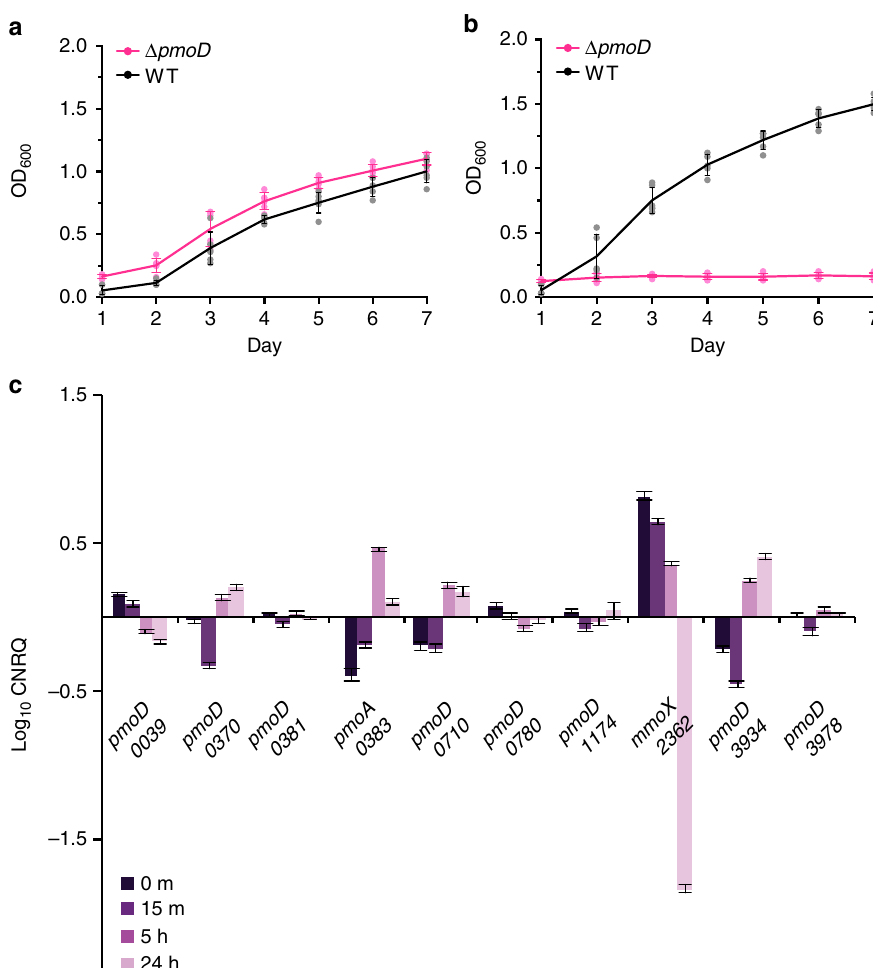
Fig. 3 In vivo characterization of PmoD MettrDRAFT_0381 . a Growth curves of wild-type (black) and Δ pmoD (pink) Methylosinus trichosporium OB3b under copper starved conditions. Error bars represent s.d., n = 5 – 6. b Growth curves of wild-type (black) and Δ pmoD (pink) Methylosinus trichosporium OB3b grown in the presence of 10 μ M CuSO 4 . Error bars represent s.d., n = 5 – 6. c qPCR analysis of pmoD genes in Methylosinus trichosporium OB3b at four timepoints (0 min at 0 μ M CuSO 4 , 15 min at 12.5 μ M CuSO 4 , 5 h at 12.5 μ M CuSO 4 , 24 h at 12.5 μ M CuSO 4 ) . Regulatory changes are shown as log 10 - transformed normalized relative quantities (NRQs). The four-digit code beneath the gene name represents the locus tag (in MettrDRAFT_NNNN format). Two non- pmoD genes are included for comparison: components of the two MMOs, pMMO ( pmoA_0383 ) and sMMO ( mmoX_2362 ), which are reciprocally regulated by copper. The clearest copper-responsive regulation is observed for the copC -adjacent pmoD MettrDRAFT_0039 (the genes are both copper down-regulated, and regulatory changes are correlated with those observed for components of the mmo and mbn operons) and for the pCu A C -adjacent pmoD MettrDRAFT_3934 (the genes are both copper up-regulated, and regulatory changes are correlated with those observed for components of the pmo operon and csp1 ). Error bars represent standard error between three biological replicates, each containing three technical replicates. Data points are